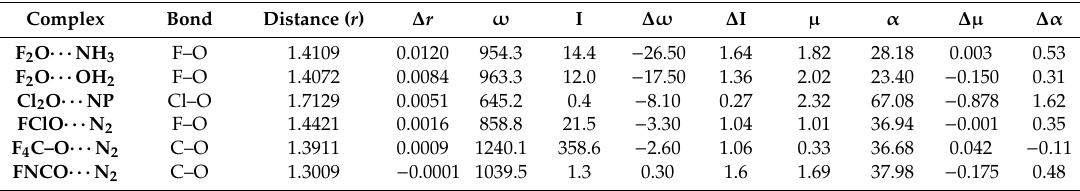
Table 1. Selected physical properties of the six binary complexes (Figure 3), obtained using MP2 / aug-cc-pVTZ a,b